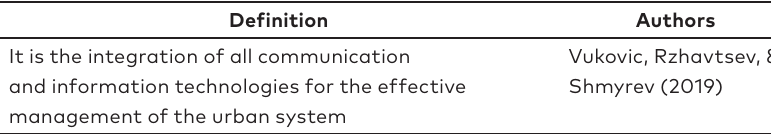
Table 1. Definitions of a smart